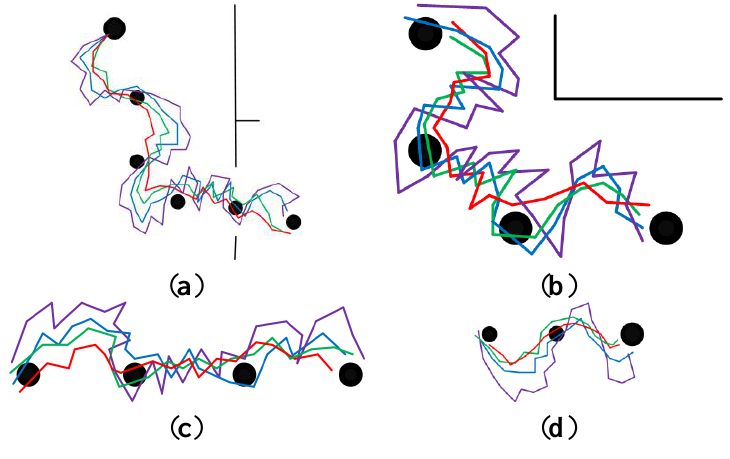
Figure 12. The homing trajectories in randomly changing environments. ( a – d ) show the results obtained in phase 1, 2, 3 and 4, respectively. Red lines correspond to the proposal. Violet lines correspond to SURF. Blue lines correspond to the proposal without selection and updating. Green lines correspond to the proposal without updating. In each figure, the robot moves from left to right, the black disks with the same size are intermediate nodes, and the bigger one is starting node or home